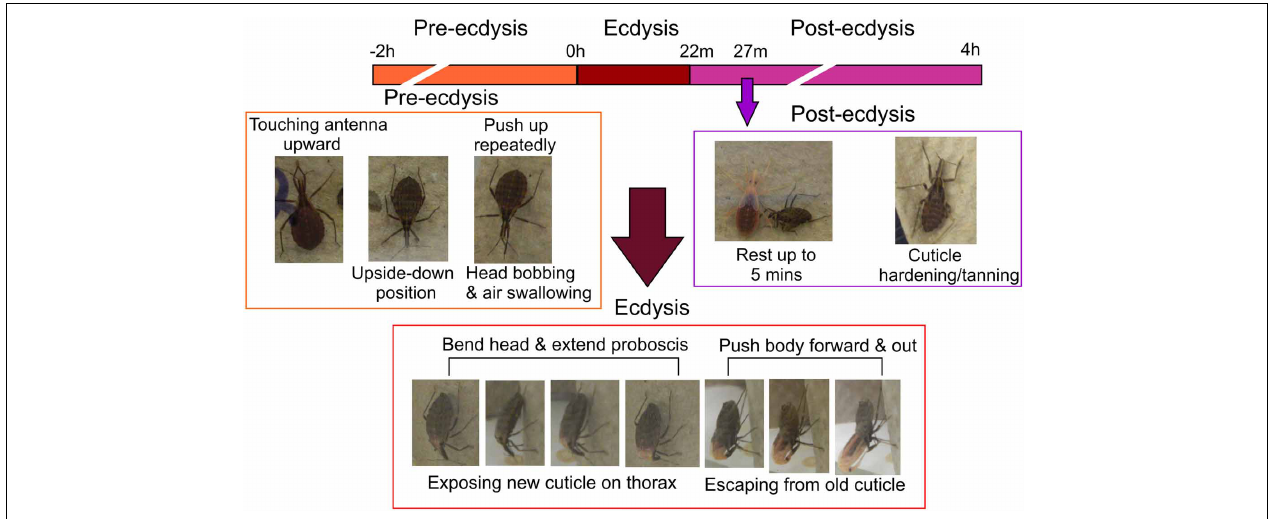
different colors. Purple arrow denotes the end of the 5min quiescent stage at the beginning of post-ecdysis. Observations based on 20 insects.